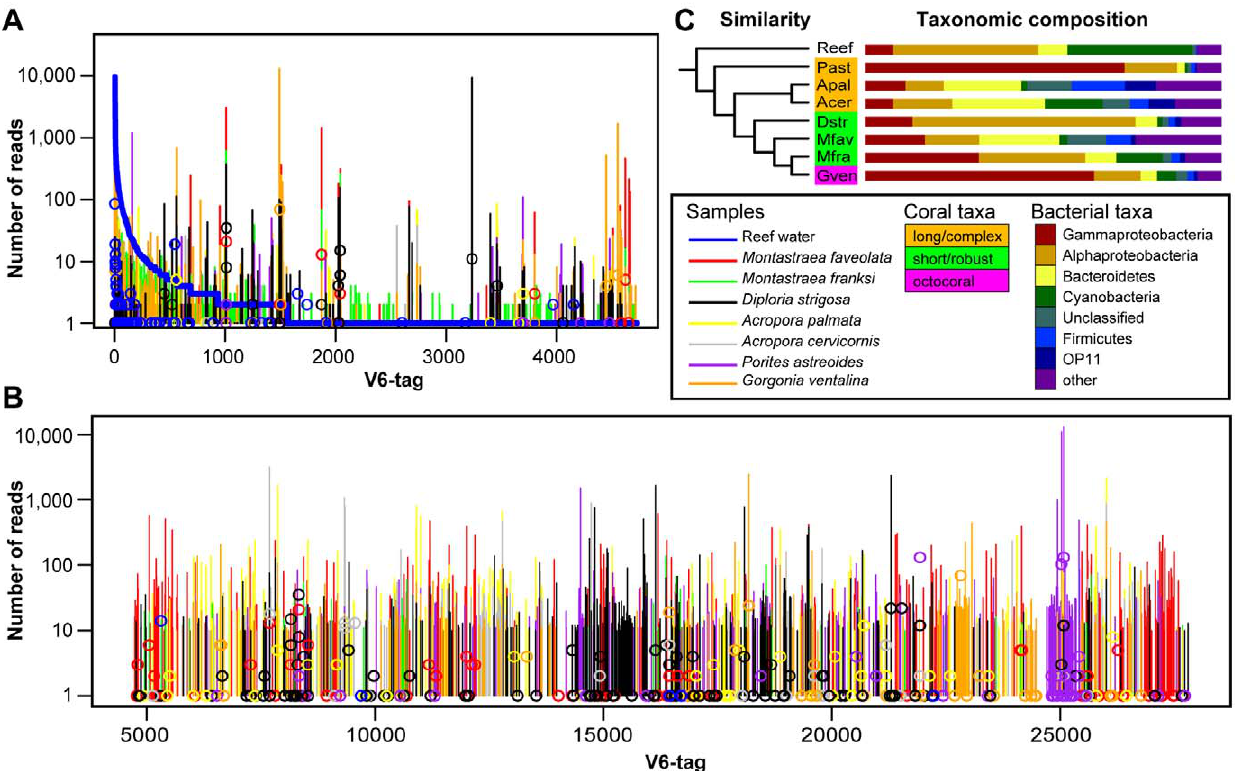
Figure 1. V6-tag abundance profiles, similarity clustering, and taxonomic composition of bacterial communities. (A) Rank abundance curve for V6-tags detected in reef water superimposed with abundances found in coral samples shown as vertical colored bars. (B) Abundances of V6- tags, which were detected exclusively in corals, are shown alphabetically sorted by taxonomic classification of V6-tags (x-axis). In (A) and (B), circles denote log-scaled abundances of nearly full-length 16S rRNA gene sequences that were mapped to the respective V6-tag sequences. (C) Taxonomic composition of all samples and dendrogram of OTU abundances showing similarities between samples, which are color-coded according coral host taxonomy. Details on the taxonomic composition of each sample can be found in Table S1. Abbreviations used: Acer= Acropora cervicornis ; Apal= Acropora palmata ; Dstr= Diploria strigosa ; Gven= Gorgonia ventalina ; Mfav= Montastraea faveolata ; Mfra= Montastraea franksi ; Past= Porites astreoides ; Reef=reef water.